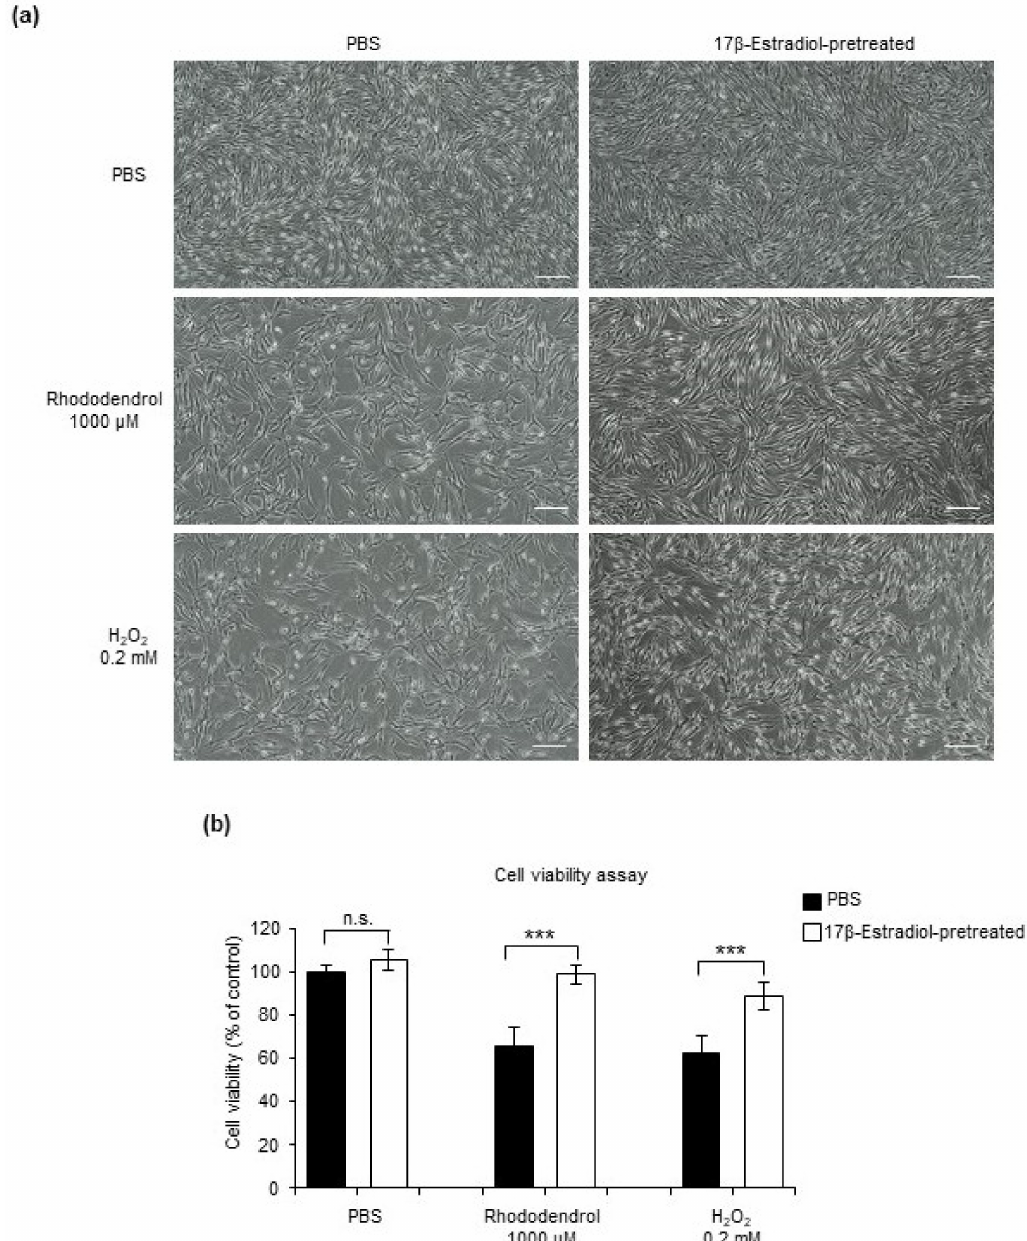
Figure 4. Estradiol protects melanocytes against oxidative stress. ( a ) Representative bright-field cell morphology images of cultured melanocytes with the indicated treatment. White bar, 50 µ m. ( b ) Cell viability assay of cultured melanocytes with the indicated treatment. Data in (b) are shown as means ± SD; n.s., no significant difference; *** p <